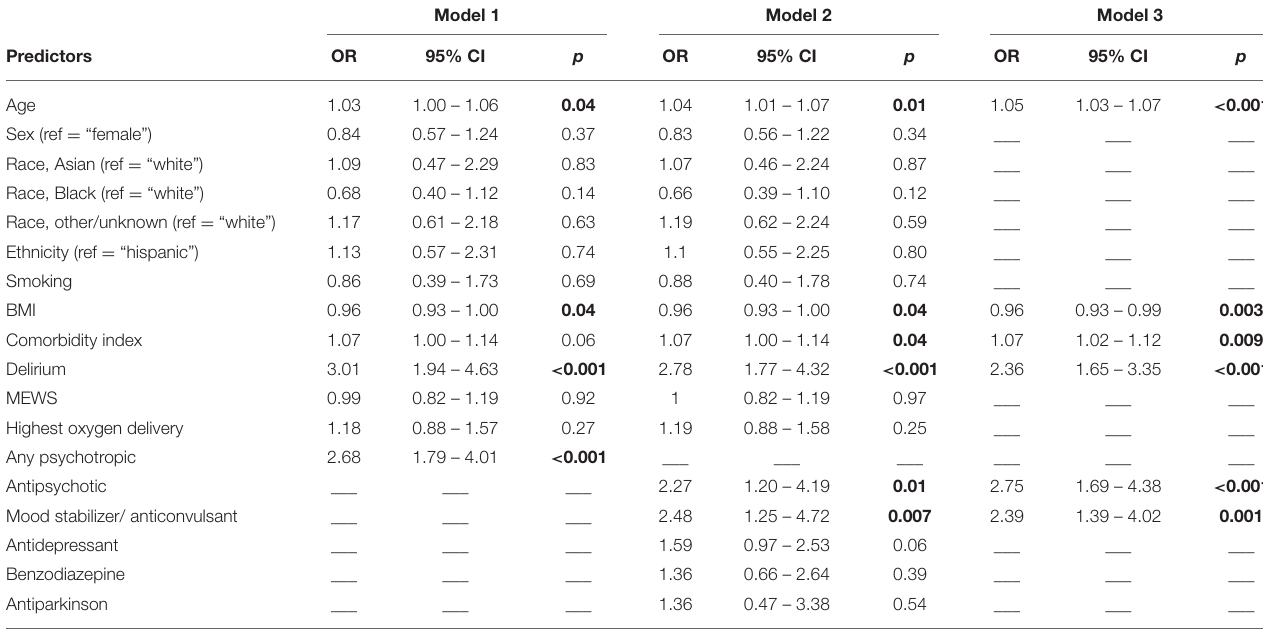
TABLE 2 | Multivariable logistic regression for variables associated with 1-year incident dementia in older adults hospitalized with COVID-19 ( n =